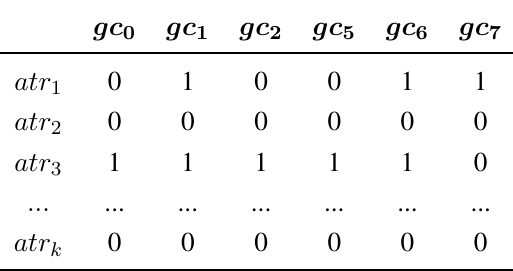
Table 3. An example of the GC-attribute table, where gc specifies the j -th attribute. The value 1 means that the sensor nodes in a certain grid cell (e.g., gc ) are interested in a certain attribute (e.g., atr 1